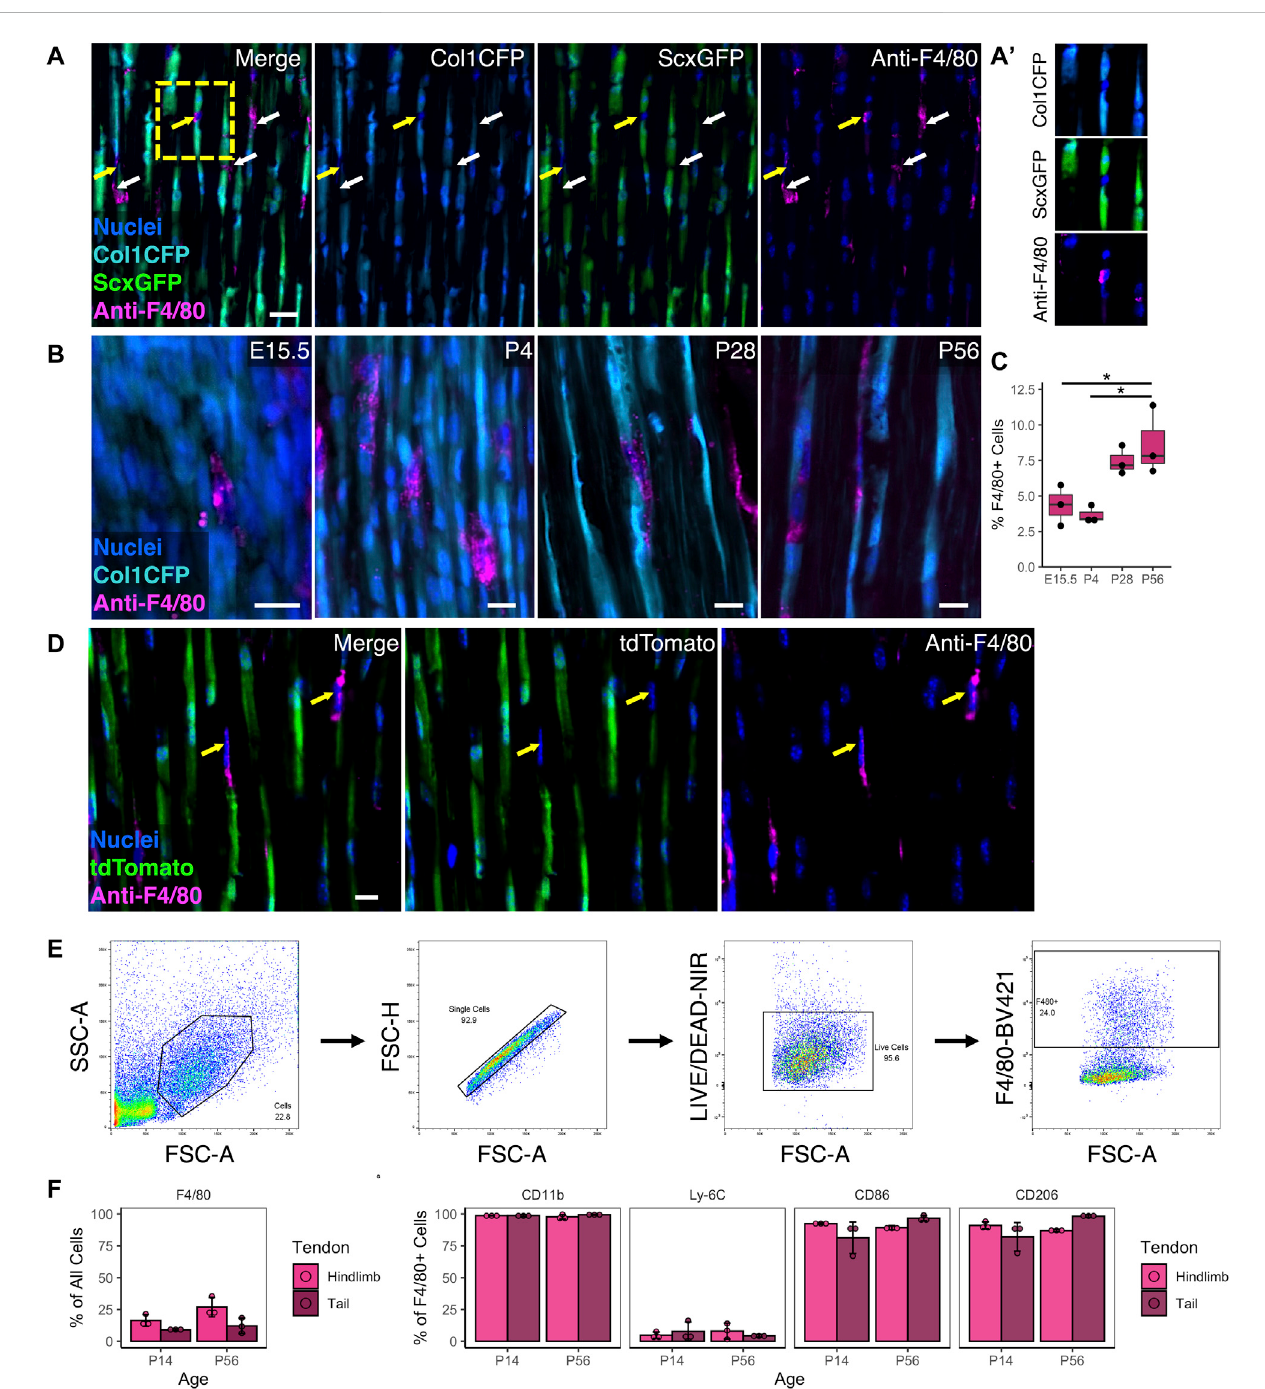
FIGURE 1 Resident macrophages are positioned adjacent to fi broblasts during tendon development and postnatal growth (A) Representative image of P28 Col1CFP;ScxGFP patellar tendon section immunostained for pan-macrophage marker F4/80 at P28 showing that Col1CFP − ScxGFP – cells are F4/80 + macrophages. Yellow arrows indicate F4/80 + macrophages with nuclei in plane; white arrows indicate F4/80 + cytoplasmic projections (A ’ ) Inset of F4/80 + macrophage within linear array of fi broblasts. Scale bar = 20 µm (B) Representative images of E15.5, P4, P28, and P56 Col1CFP patellar tendon sections immunostained for F4/80. Scale bar = 10 µm (C) Quanti fi cation of F4/80 + cells in patellar tendon sections. Data shown as mean ± SD ( n = 3). * p < 0.05 as determinedbyone-wayANOVAwithTukey ’ spost-hoctest (D) F4/80immunostainingonP28ScxCre;Ai9patellartendonsectionsdemonstratingthatF4/80 + cells are not tdTomato + . Scale bar = 10 µm (E) Representative images of gating strategy for surface marker characterization of tendon resident macrophages by fl ow cytometry (F) Percentage of F4/80 + cells in hindlimb and tail tendons at P14 and P56 (G) Percentage of marker expression within the F4/80 + population. Data shown as mean ± SD ( n = 3). There were no signi fi cant differences ( p > 0.05) between tendons or between ages as determined by Mann Whitney U